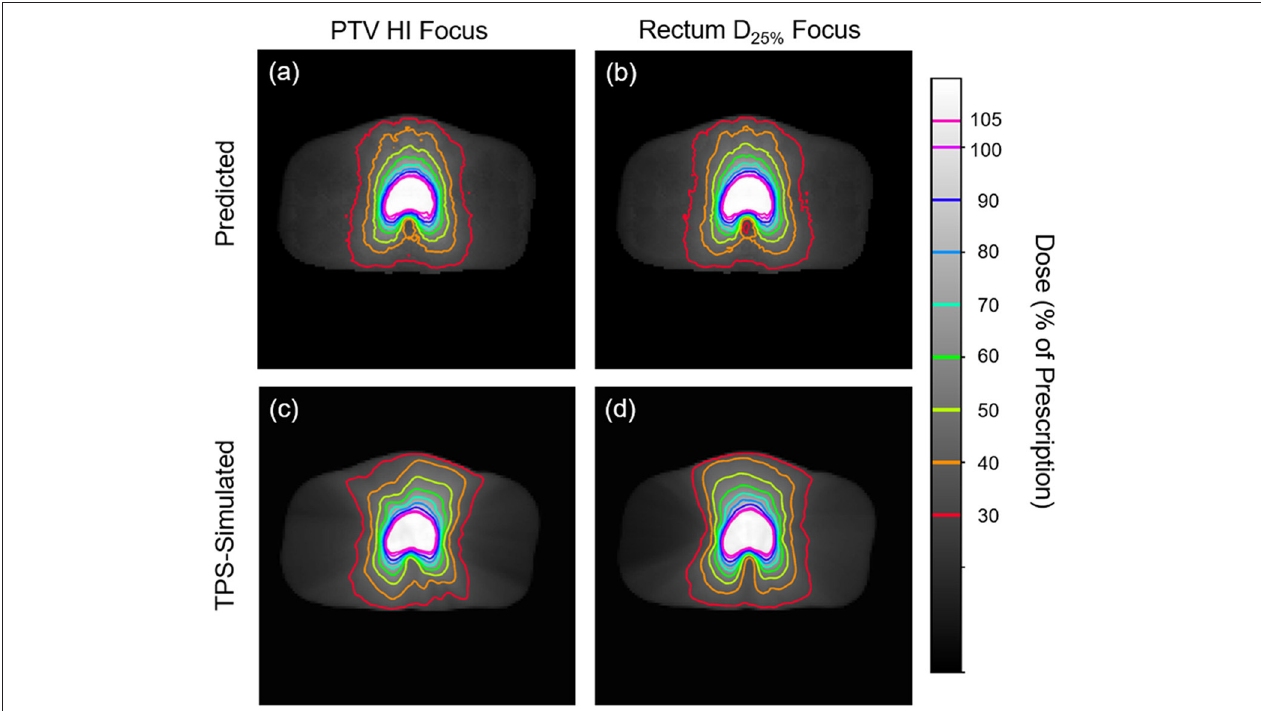
FIGURE 5 | Side-by-side comparisons between the effect of prioritizing PTV HI (a,c) or prioritizing rectum D 25 % (b,d) in a dose map prediction (a,b) and its corresponding TPS-simulated dose map (c,d) . Transverse slices are taken from the center of the PTV, and the patient was randomly sampled from the testing dataset.